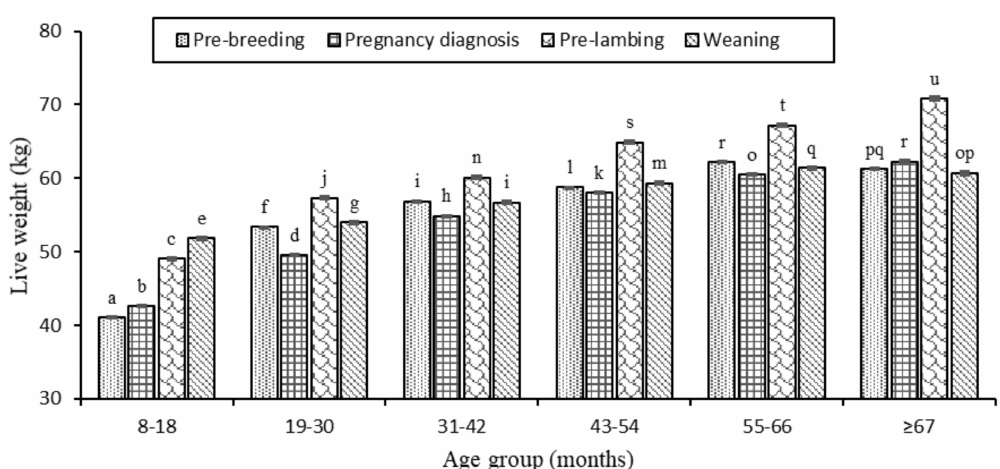
Figure A3. The liveweight of ewes across each age group (8–18 months, 19–30, 31–42, 43–54, 55–66 and ≥ 67) and stage of the annual cycle (dotted bar, pre-breeding; grid, at pregnancy diagnosis; shingled, pre-lambing; and stripped-diagonal, weaning). Superscripts a–u indicate significant di ff erences ( p < 0.05) across age group and stage of the annual cycle.